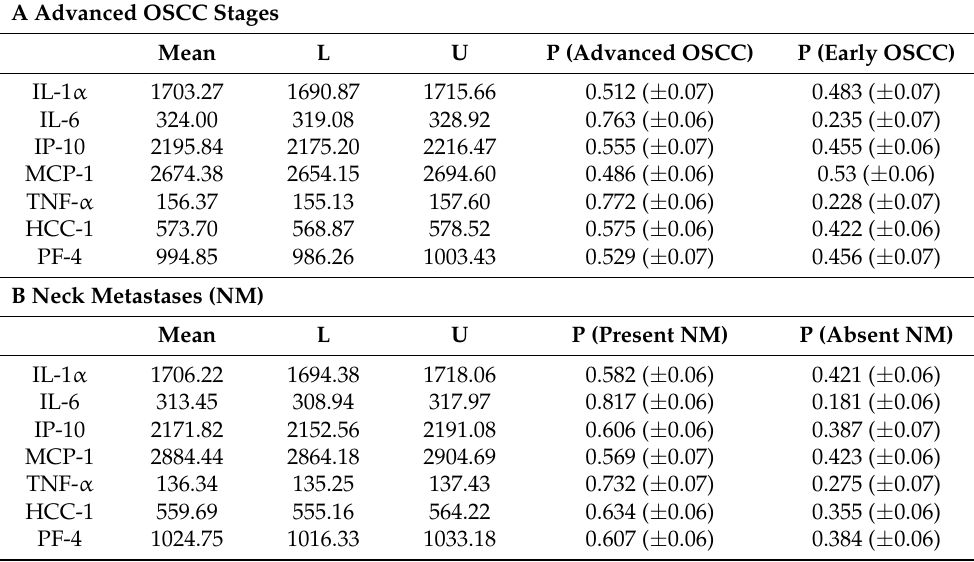
Table 5. Conditional concentration ranges of salivary cytokines (pg/mL) that maximize the probabil- ity of association with ( A ) advanced OSCC and ( B ) the presence of neck metastases in OSCC patients (early + advanced